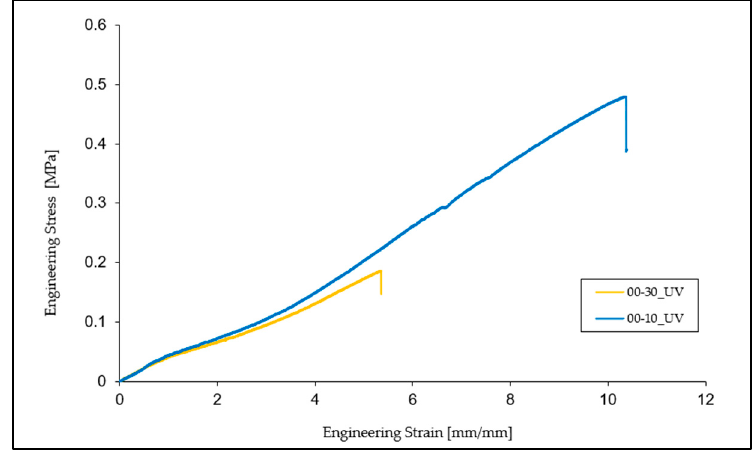
Figure 9. Comparative average of specimens 00-30 and 00-10 at UV.